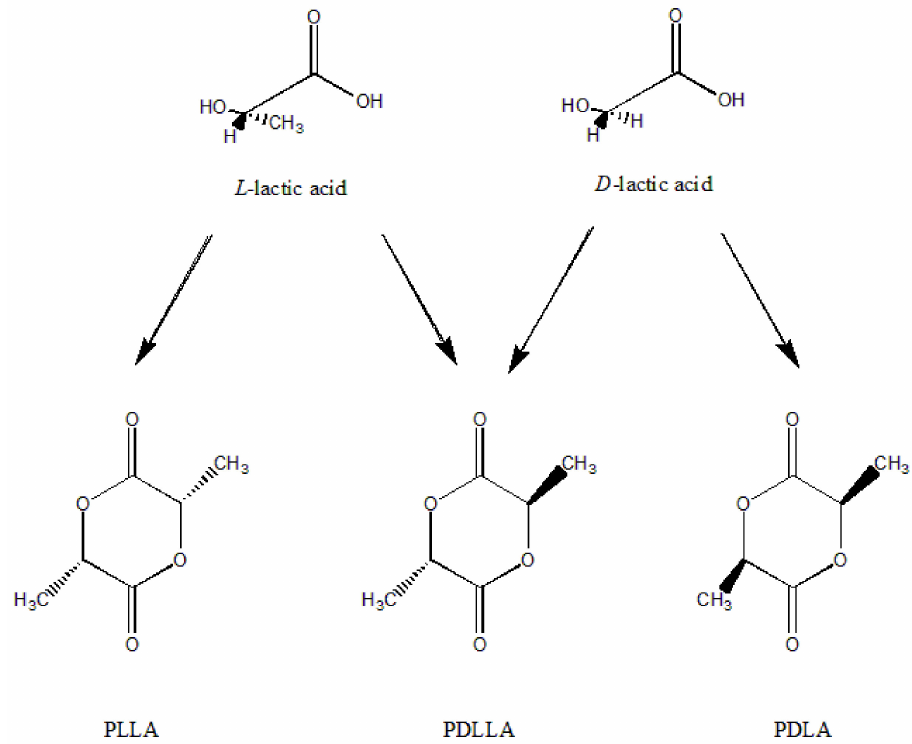
Figure 1. The structure of lactide and lactic acid.